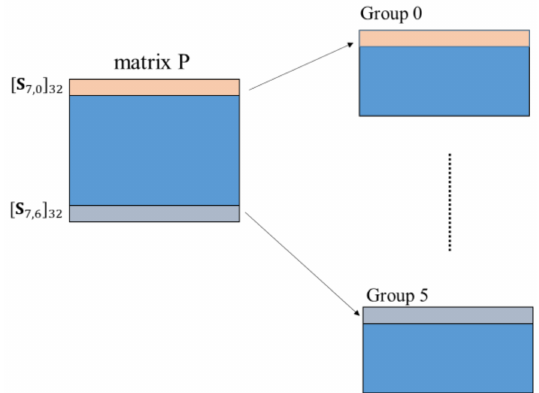
Figure 6. Illustration of kernel derivation using grouped DST-7 matrix.